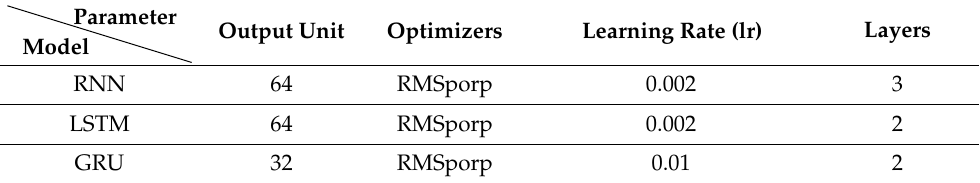
Table 9. Experimental parameters for RNN, LSTM and GRU prediction models.